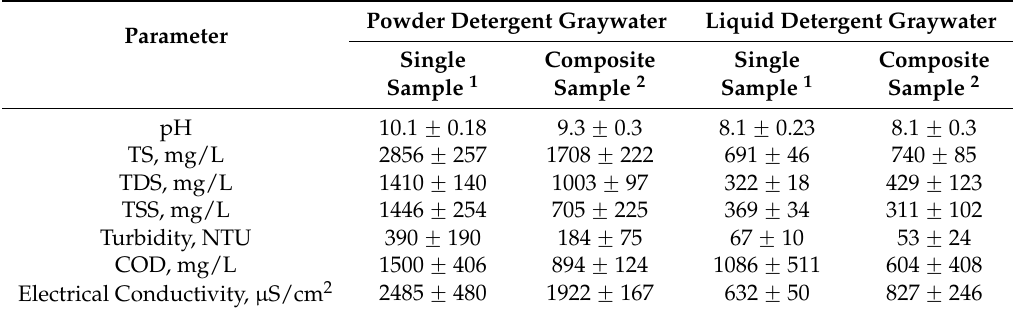
Table 2. Bulk characterization of graywater for two types of detergent ( n = 16).